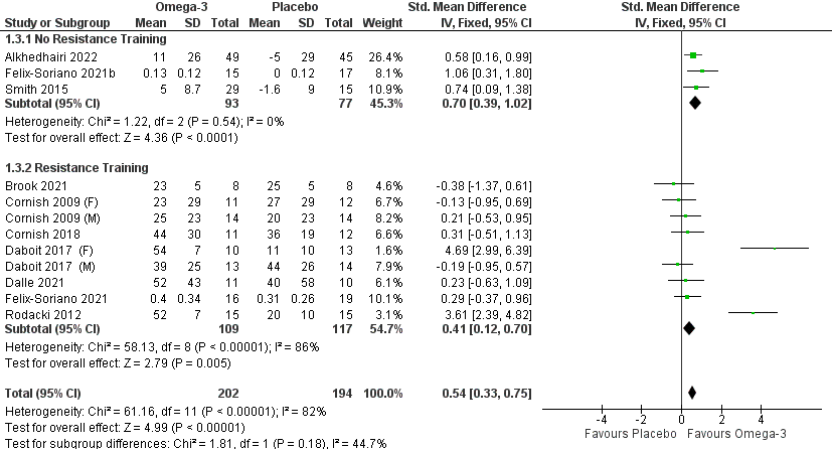
Figure 3. Pooled analysis of the impact of omega-3 supplementation on lower body strength with and without resistance training